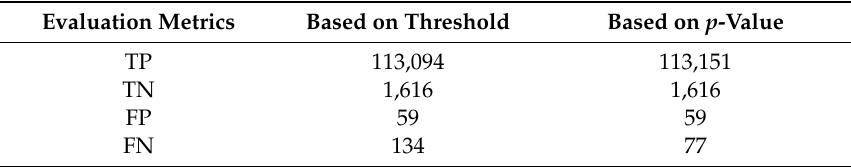
Table 3. Comparison of confusion matrix based on Logistic Regression (LR) results.